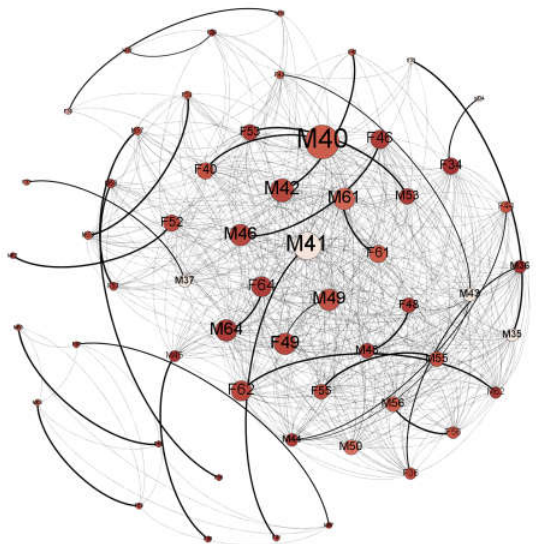
Figure A3. The inferred social network among Latino participants from all three communities combined. The link width was scaled by the likelihood of social connection. The label “F” stands for “Father” and “M” for “Mother”. The size of nodes indicates their weighted degree centrality, and the tone of color shows their mental well-being scores (the darker the color, the greater the mental well- being).